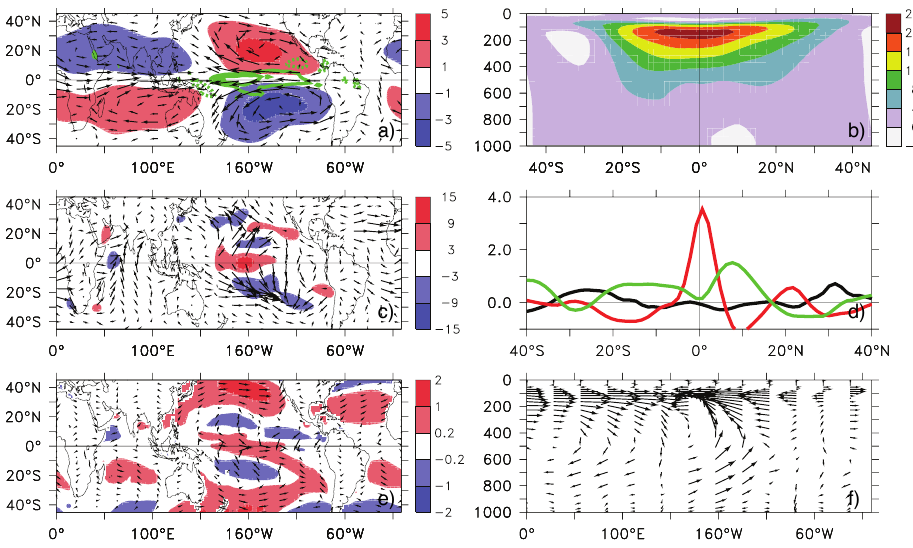
Fig. 4. Annual-mean climatological NINO − MODERN anomalies in the tropical region. (a) Zonally asymmetric component of the stream- function (shading, units of 10 7 m 2 s − 1 ) and wind (arrows, longest about 30ms − 1 ) averaged over 100–200mb. Green contours show con- vective precipitation rate at intervals of 10 mm day − 1 , negative dashed. (b) Zonal-mean zonal wind (m s − 1 ). (c) Stationary wave activity flux (arrows, longest about 100m 2 s − 2 ) and its convergence (shading, units of ms − 1 day − 1 ), averaged over 100–200mb. (d) Zonal-mean zonal momentum tendency (units of ms − 1 day − 1 ). (e) Horizontal wind in the lowest model layer (arrows, longest about 8ms − 1 ) and zonal surface wind stress over ocean (shading, units of 0.1Nm 2 ). (f) Zonally asymmetric component of the zonal-vertical wind in the equatorial region, averaged 5 ◦ S–5 ◦ N. Longest arrows indicate a horizontal component of about 20ms − 1 ; vertical (pressure) velocity component has been multiplied by − 100 for display